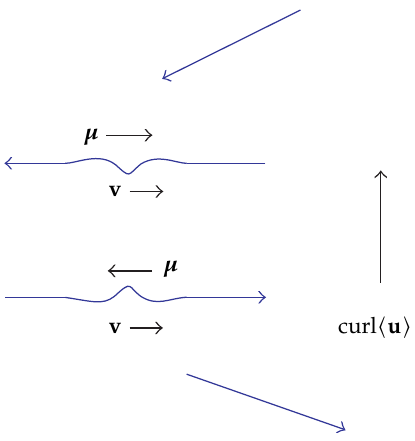
Figure 13.1 . A right-hand screw helix ( bottom ) and left-hand screw helix ( top ) traveling from the left to the right in the vortex sponge through an inhomogeneous field of fluid vorticity curl (cid:12) u (cid:13) . Arrows on the filaments indicate the direction of their vorticity, v shows the direction of the translational motion and µ the rotational moment of the